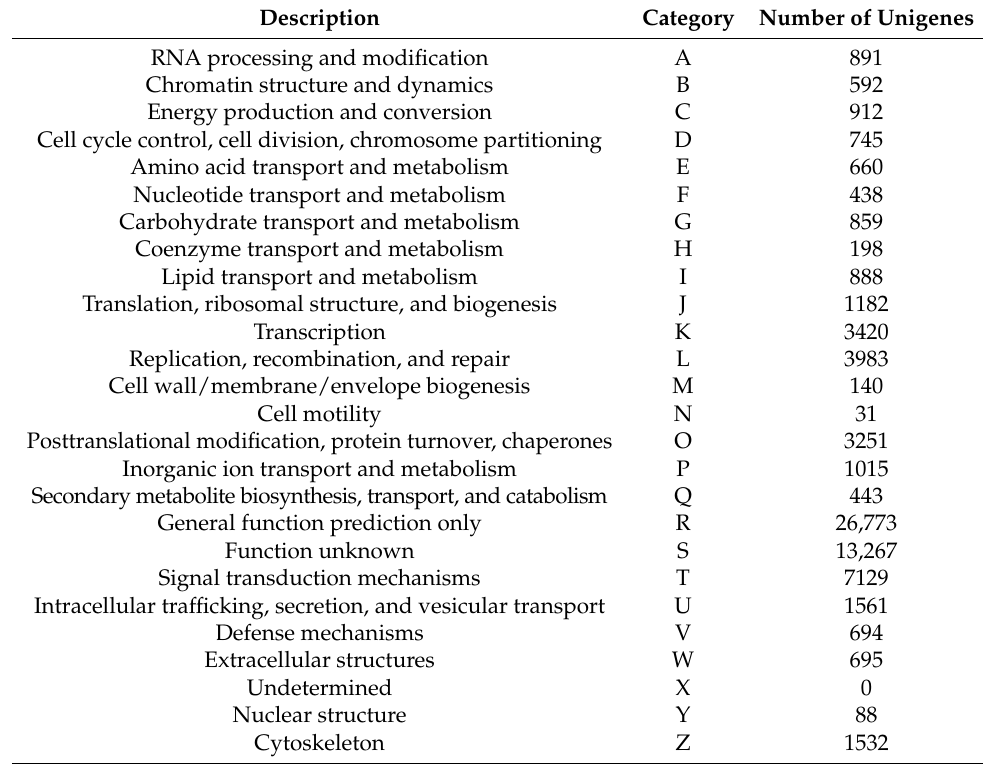
Table 6. The annotated eggNOG functions of